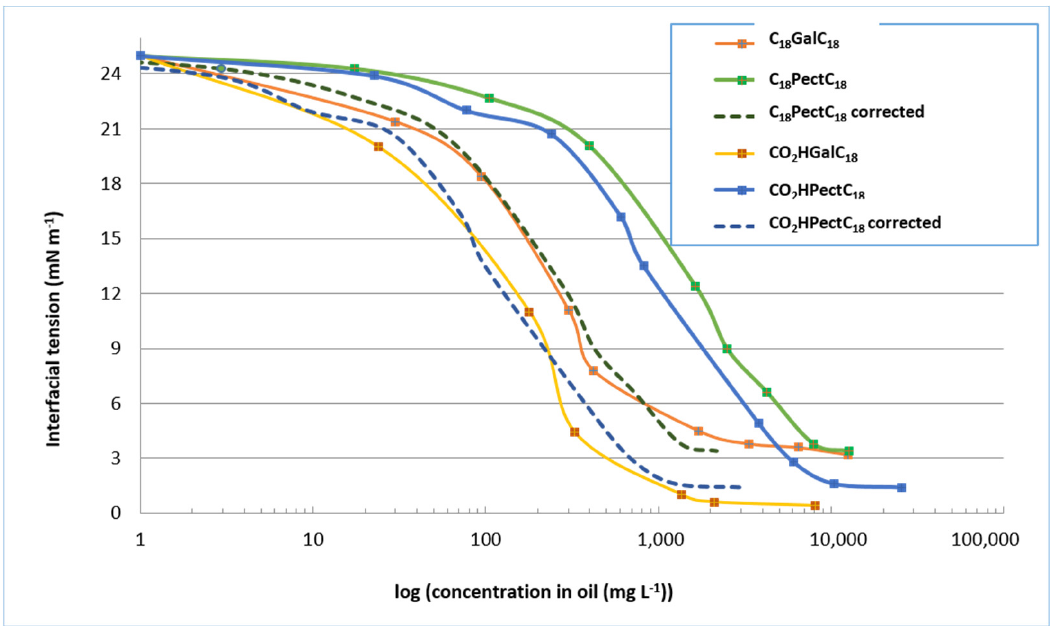
Figure 7. Values of the interfacial tension of surfactant compositions derived from oleic alcohol.